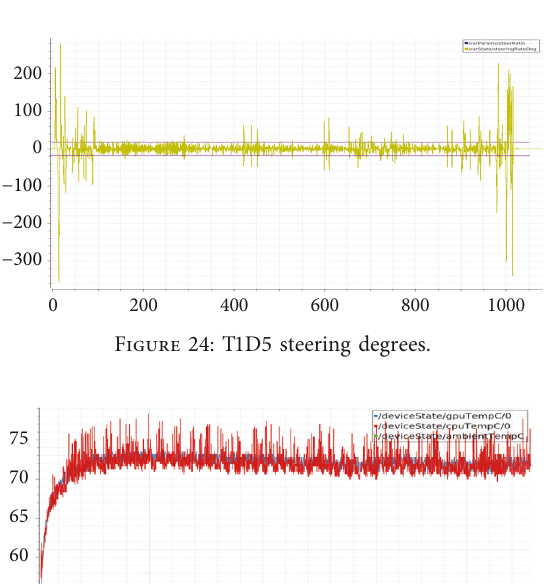
Figure 21: T1D5 left (1) and right (2) lane recognition.